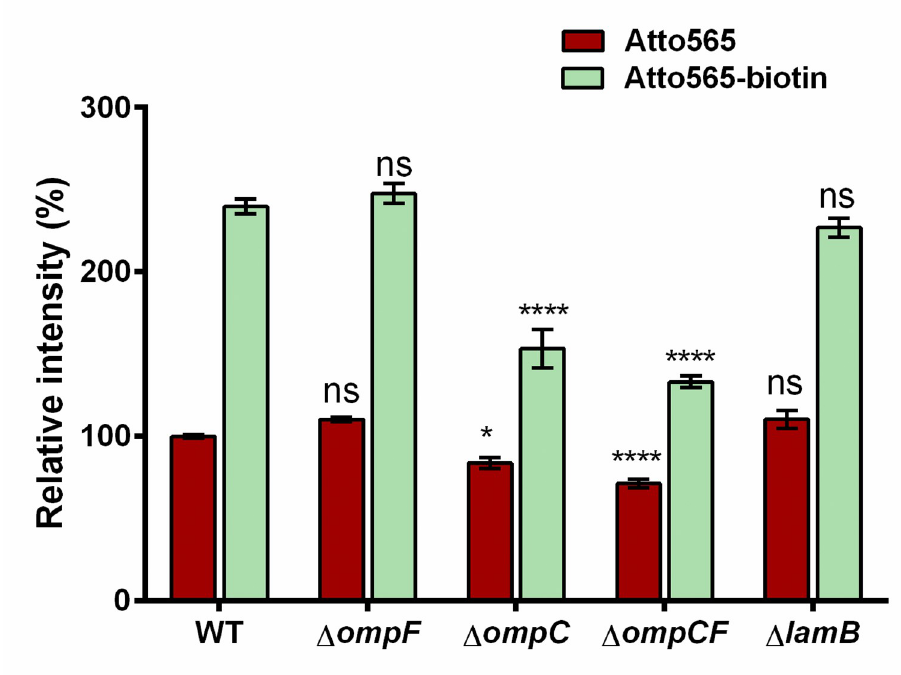
Fig 5. Accumulation of Atto565 and Atto565-biotin in wild type versus porin knock out strains. Figure shows the representative data from three independent experiments. Data were presented as mean ± S.D. (Two-way analysis of variance; ���� p < 0.0001, � p < 0.05). Asterisks above the Atto565 accumulation bar represent significance when compared them with Atto565 accumulation in WT strain, whereas asterisk above the Atto565-biotin accumulation bar represent the significance when compared with Atto565-biotin accumulation in WT